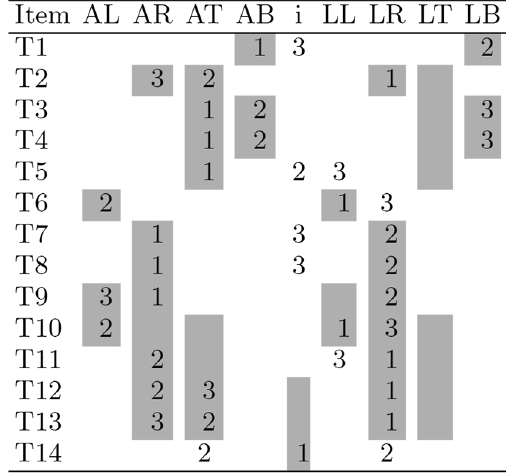
FIG. 8. Listing of the three local AOIs that receive the most attention per item. For this purpose, the TVD was normalized to the size of the AOI. Cells colored in gray indicate the AOIs that are addressed by the item text. This consists of the AOIs of the axes (A) and labels (L) in all four directions (L)eft, (R)ight, (T)op, and (B)ottom, as well as the AOI for the interior of the diagram (i).